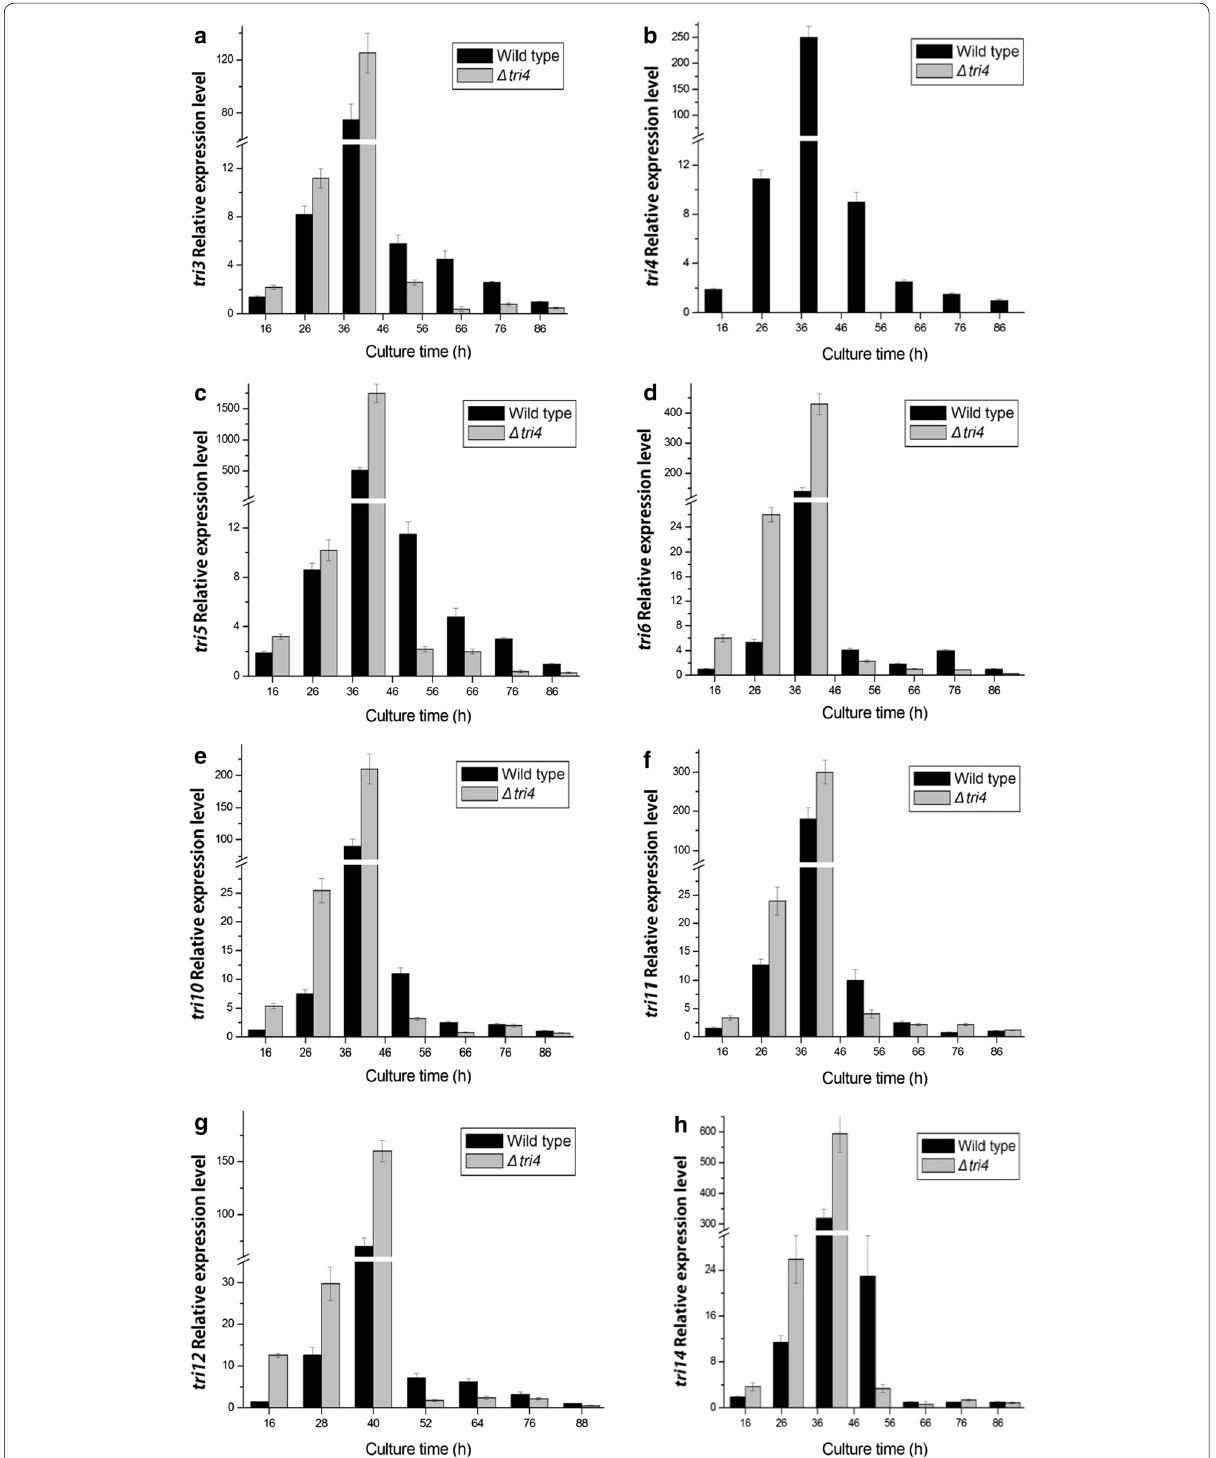
Fig. 4 Expression of tri genes in Δ tri4 mutant and wild strain. The quantification of tri4 gene expression in the different culture times was analyzed by 2 − ΔΔCt method. The wild strain cultured for 88 h was used as control and β - tubulin as reference gene. a tri3 , b tri4 , c tri5 , d tri6 , e tri10 , f tri11 , g tri12 , and h